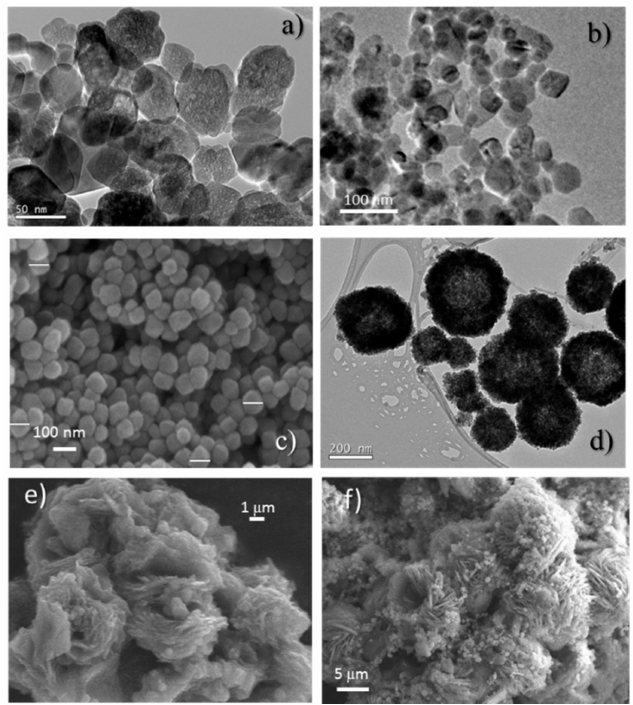
Figure 6. Representative EM images for the ( a ) Few200, ( b ) Few450, ( c ) Fe-HT, ( d ) Fe-ST1 and ( e ) Fe-ST2 fresh catalysts and ( f ) iron glycolate precursor of Fe-ST2.